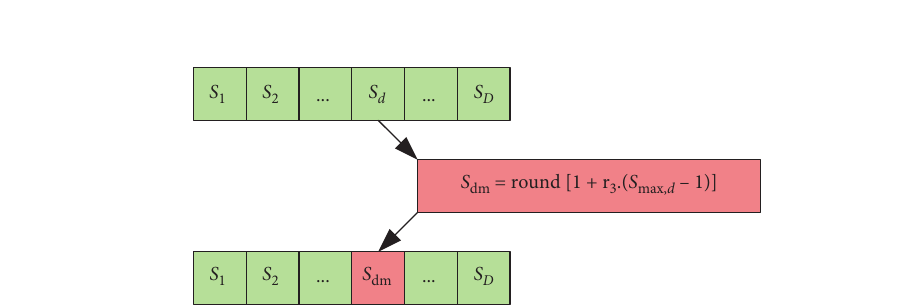
Figure 3: CGA crossover operation.